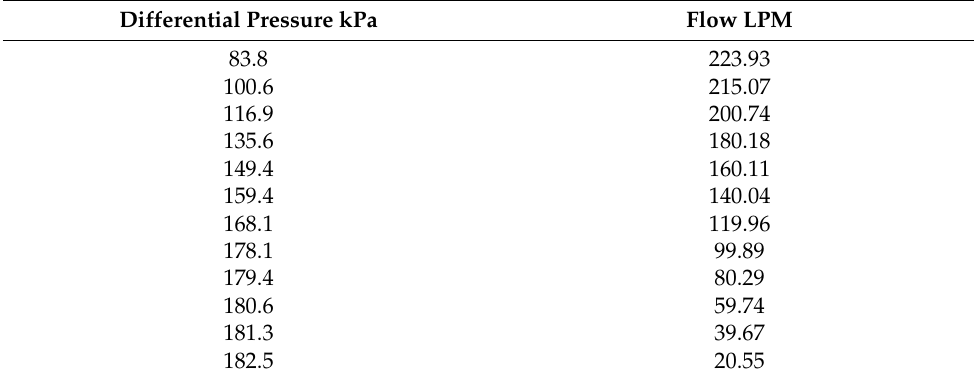
Table 3. Experimental data of differential pressure and